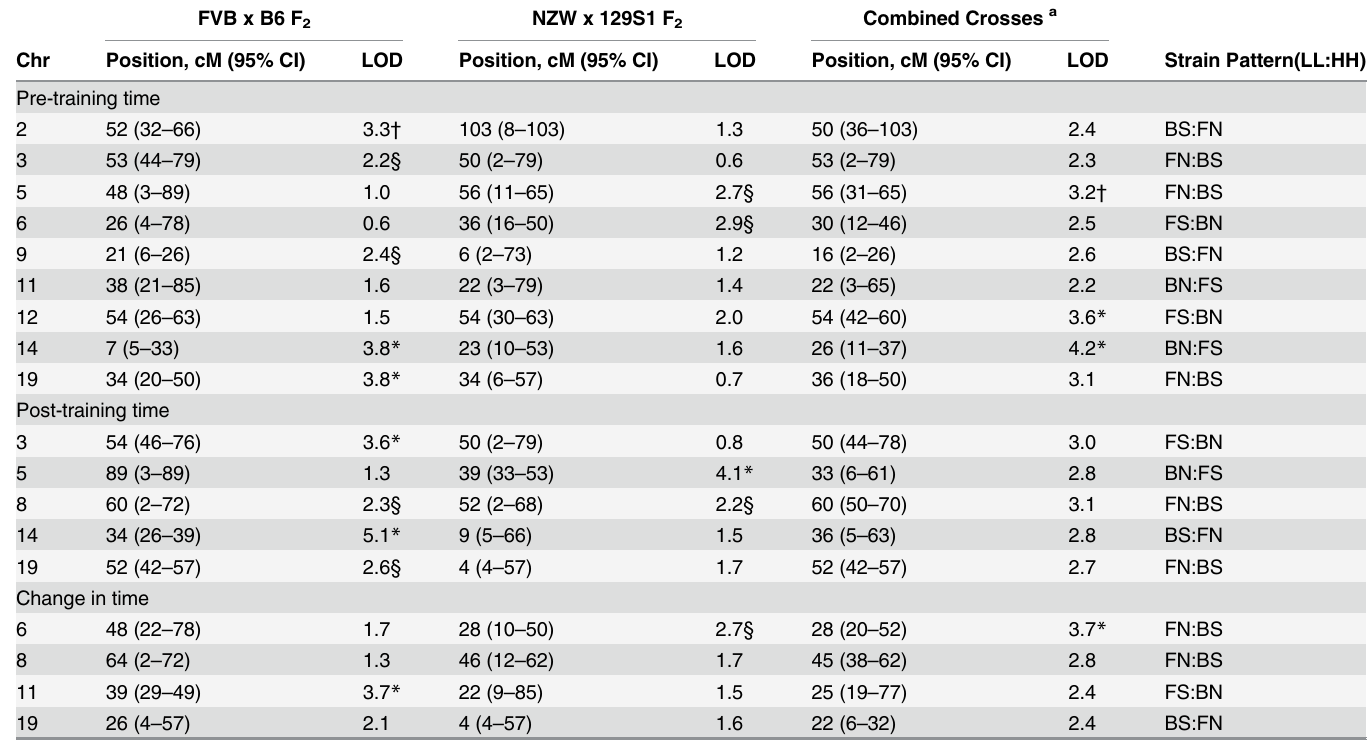
Table 3. Significant and suggestive QTL for exercise time and the response to training identified using combined cross